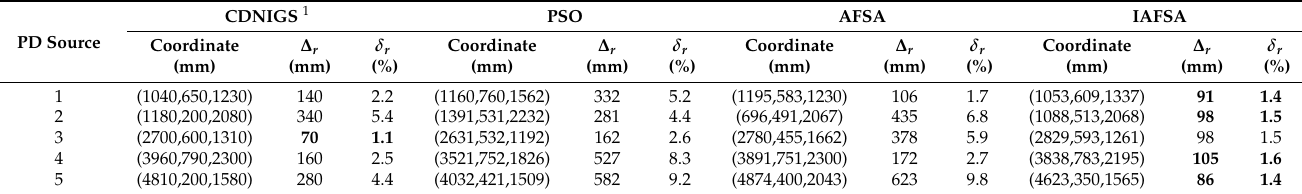
Table 5. Localizationresults and errors for the simulation.